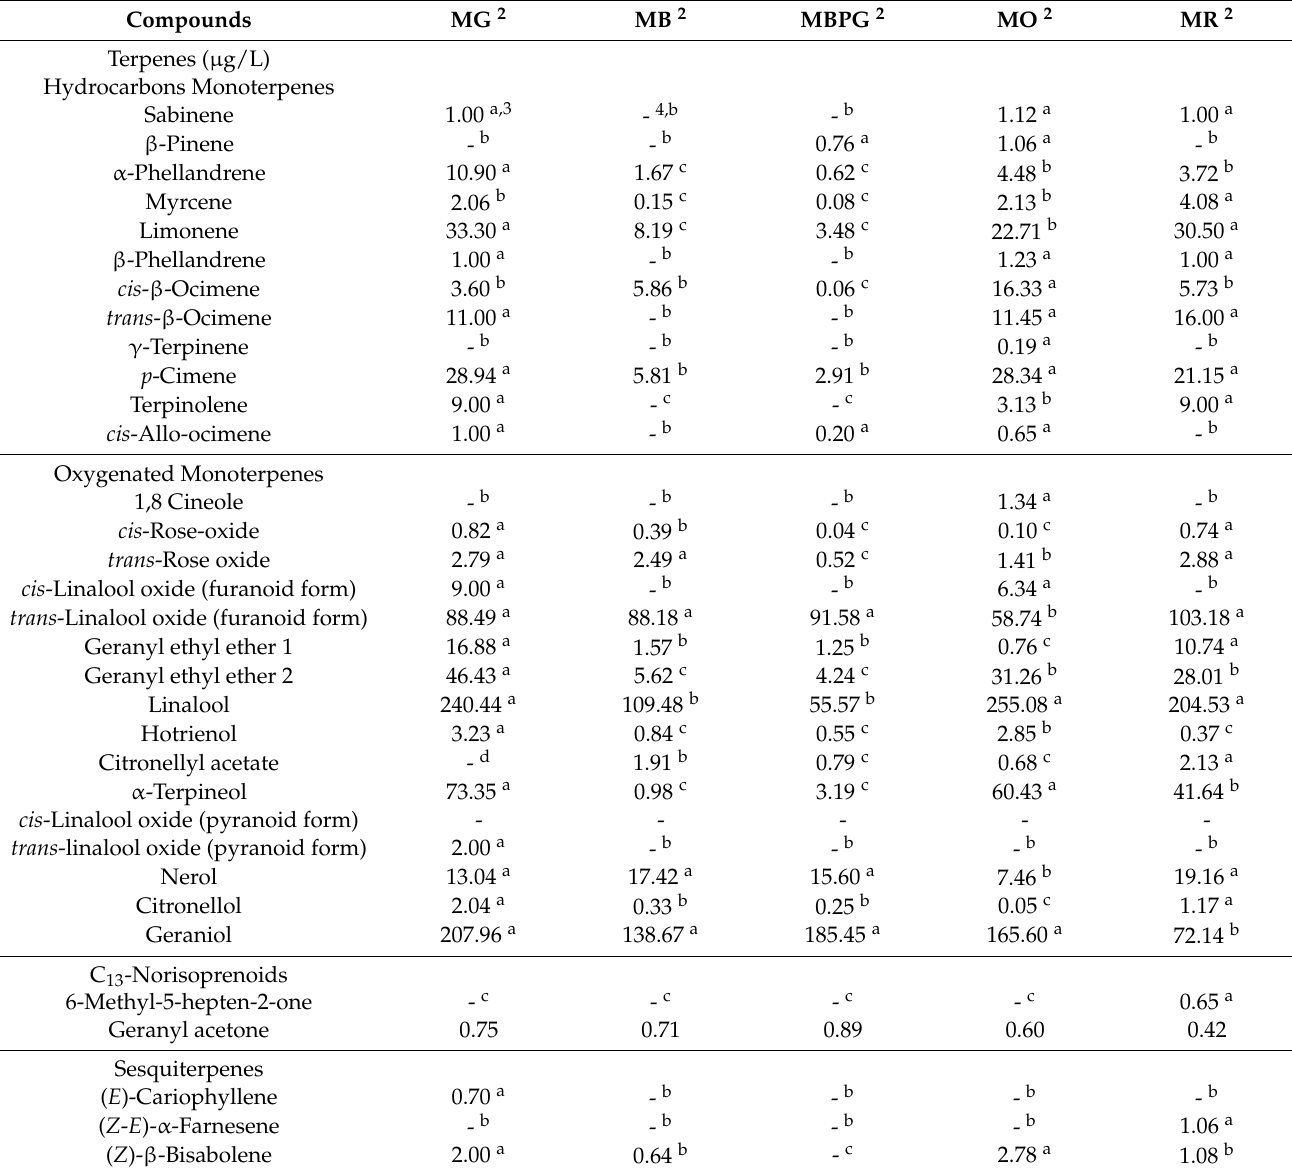
Table 3. Varietal aroma compounds quantified (average values 1 ) in fortified wines from different Moscato cv.